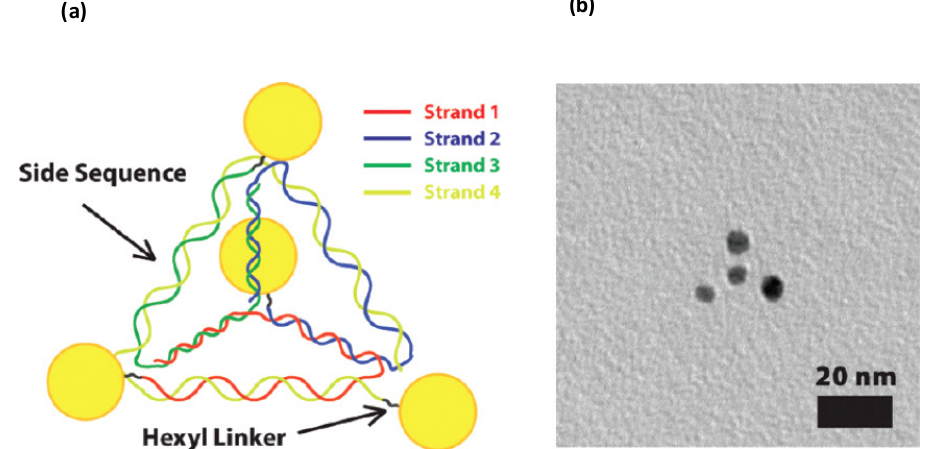
Figure 4. A DNA pyramid can be constructed using four DNA strands [50]. ( a ) Free DNA ends at each vertex can be modified with a linker sequence to attach GNPs; ( b ) Transmission electron micrograph of a single DNA pyramid-GNP complex with the four GNPs visible as black circles. Reprinted with permission from Ref [50]. Copyright 2009 American Chemical